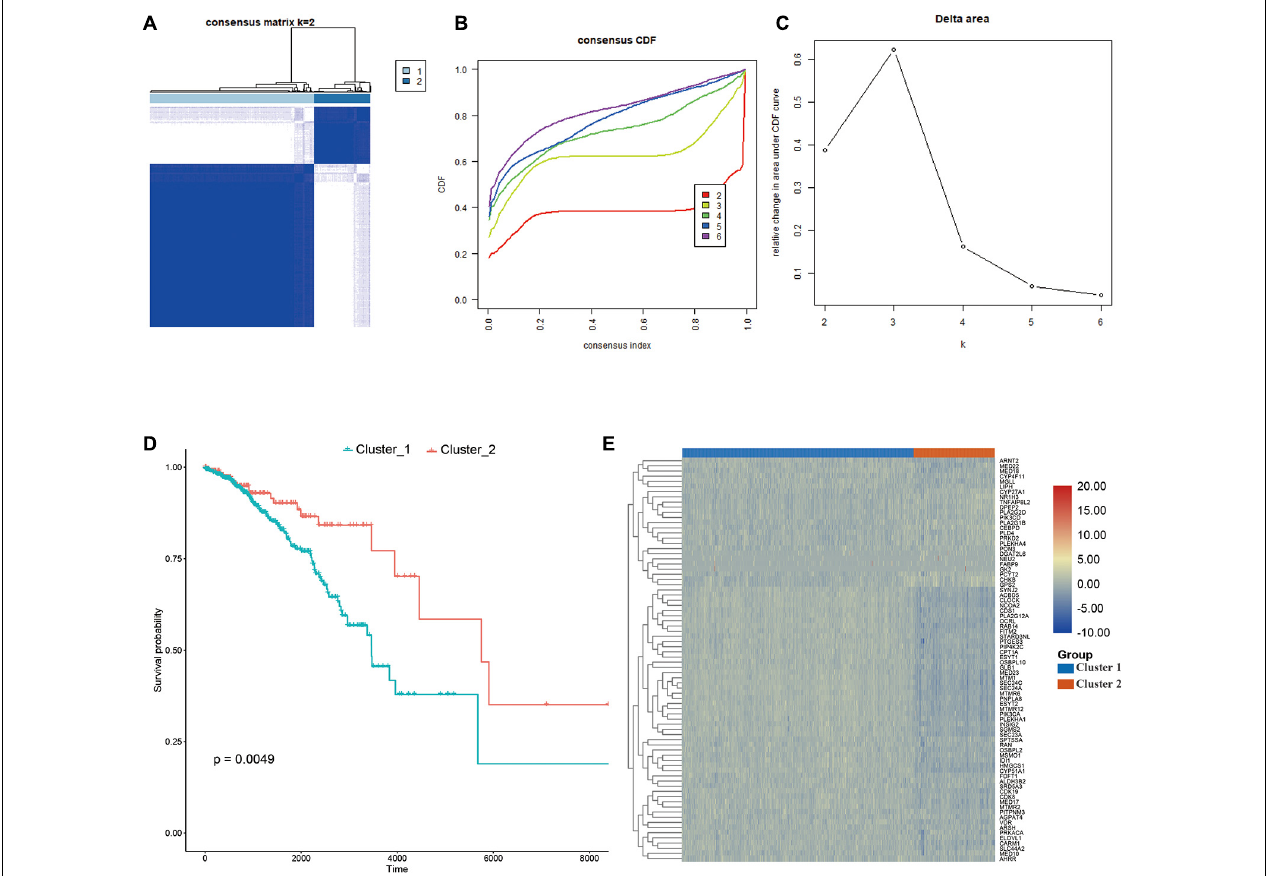
FIGURE 2 | Consensus clustering. (A–C) The clustering demonstrating the best stability with K = 2, (D) Kaplan–Meier analysis curve, (E) heatmap illustrating the different expressional pattern of the prognostic lipid metabolism associated genes in the two